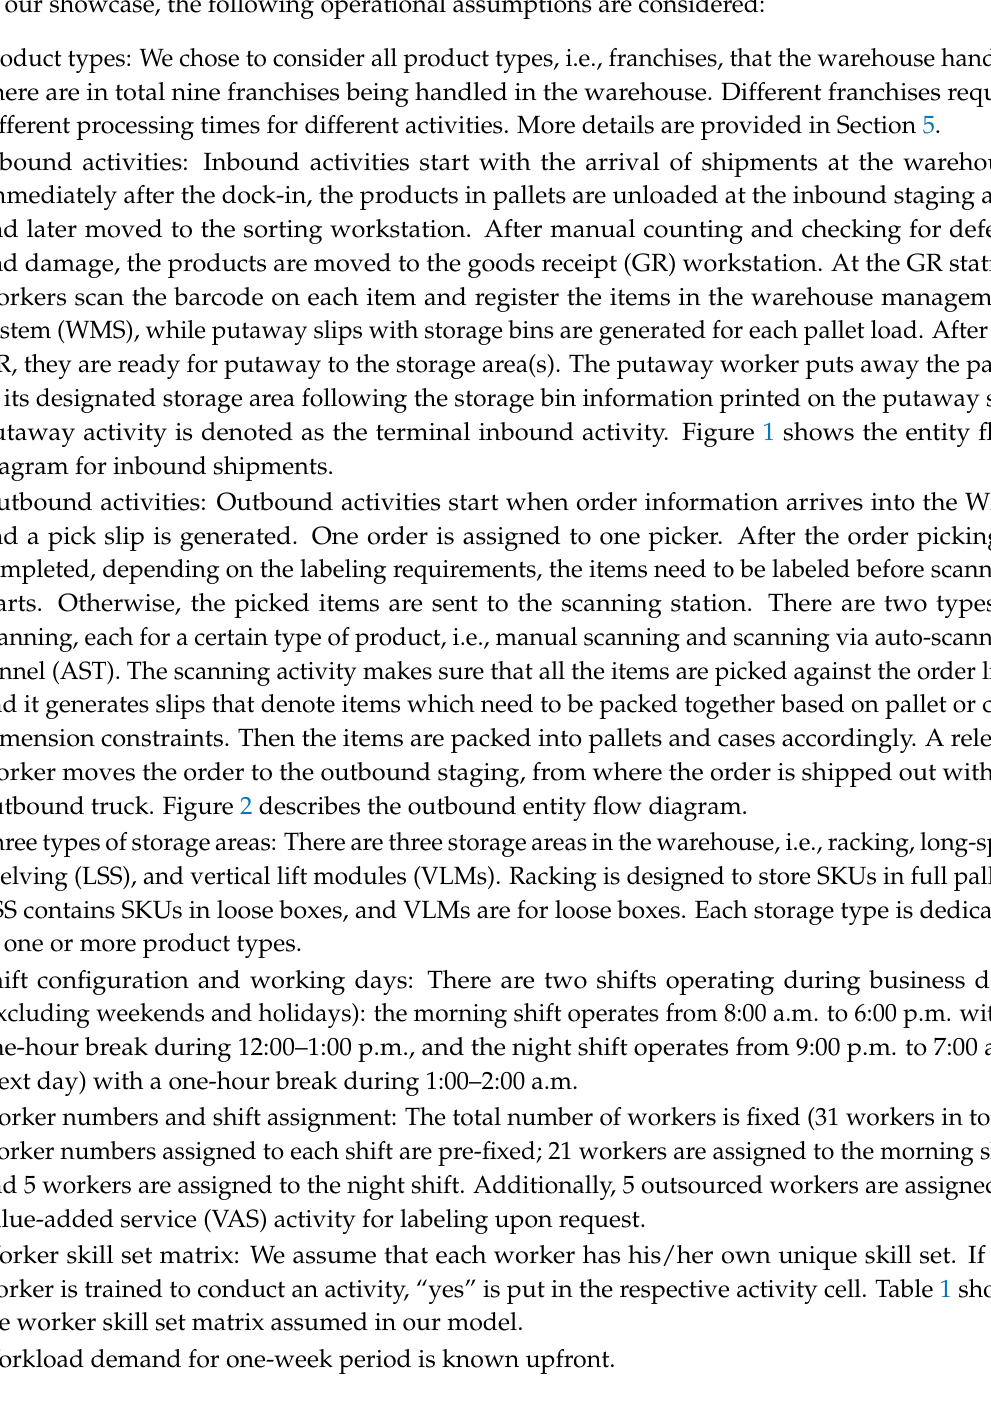
Figure 1. Inbound entity flow diagram.